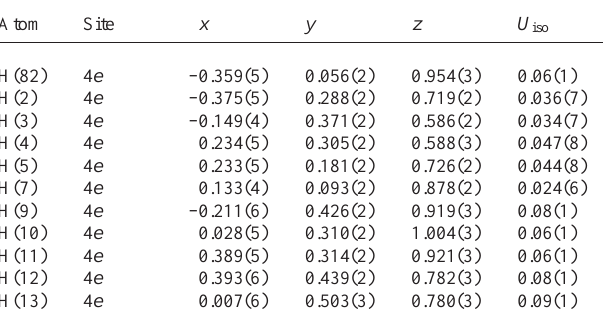
Table 2. Atomic coordinates and displacement parameters (in Å 2 )